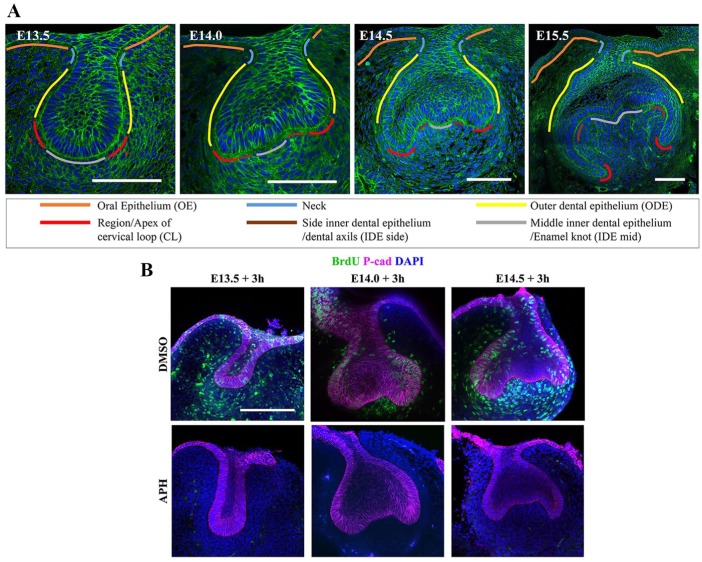
Molar tooth germs show dynamic shape change from bud to cap to bell stage. (A) Confocal images of frontally sliced tooth germs at the indicated stages were stained with phalloidin (green) for F-actin and DAPI (4′,6-diamidino-2-phenylindole; blue) for nuclei. Scale bar = 100 μm. (B) Confocal images of tooth germ explants made at the stages shown were treated with aphidicolin (APH) or vehicle as indicated, incubated for 3 h, and labeled for a further 2 h with BrdU (green). Counterstains are DAPI (nuclei, blue) and P-cadherin (magenta). Absence of green label with aphidicolin treatment shows complete inhibition of proliferation, while cells in the control group actively proliferated at 3 h of treatment. Scale bar = 100 μm for all panels.